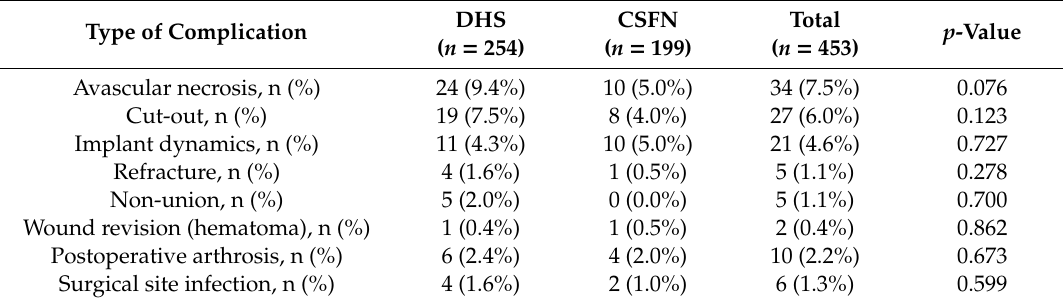
Table 2. Incidence of post-operative complications.